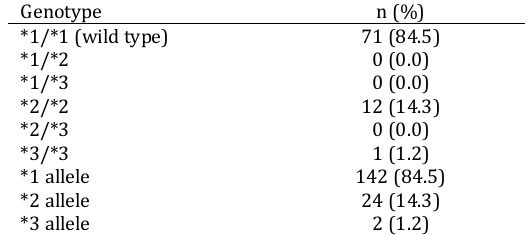
Table 1. Genotype and allele frequencies of CYP2C19 (n=84)